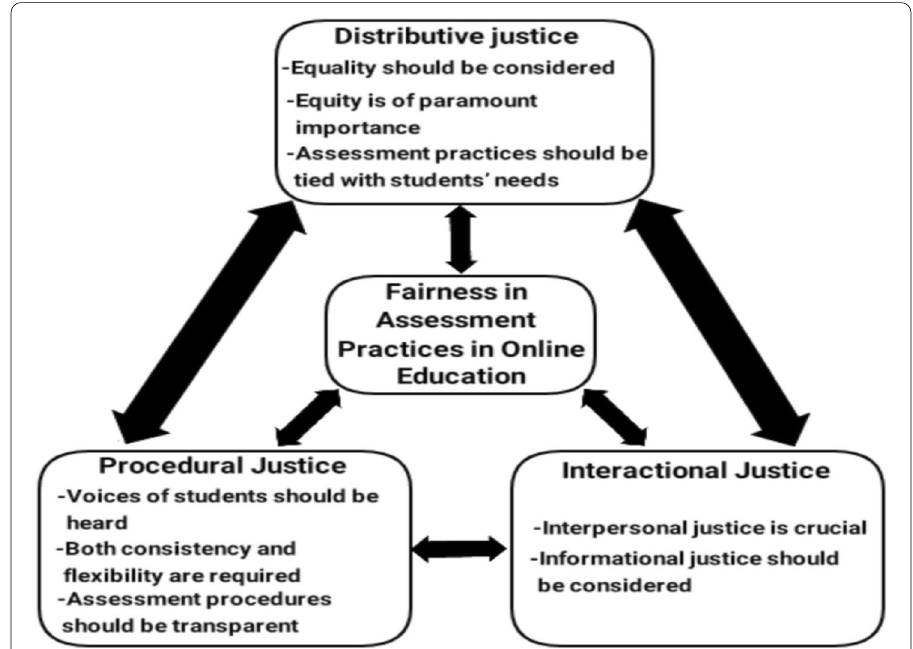
Fig. 1 A model of fairness in assessment practices in online